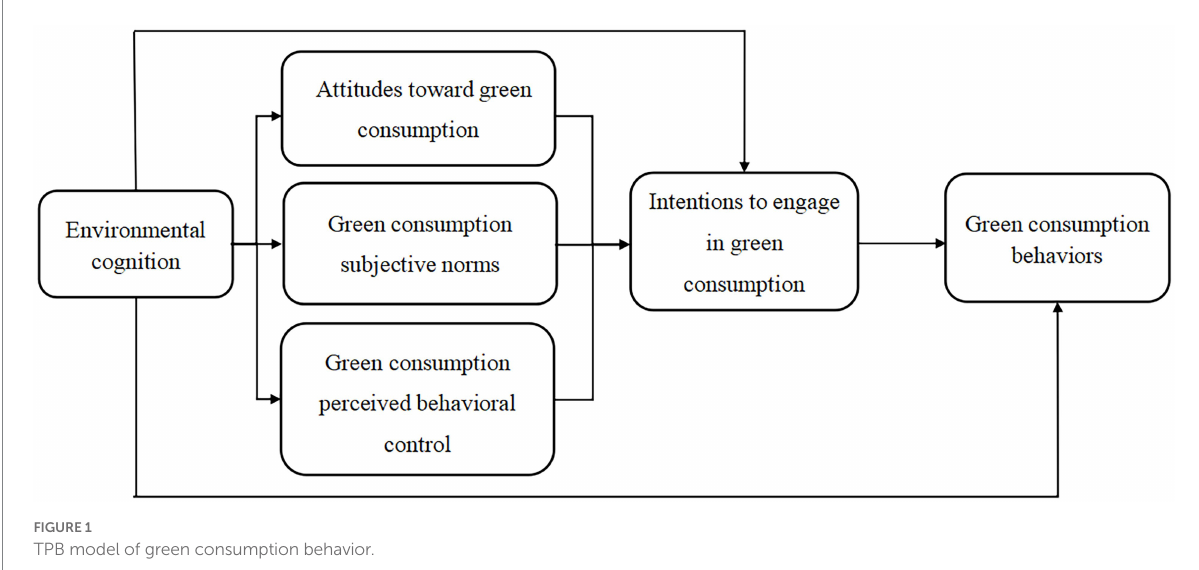
FIGURE 1 TPB model of green consumption behavior.